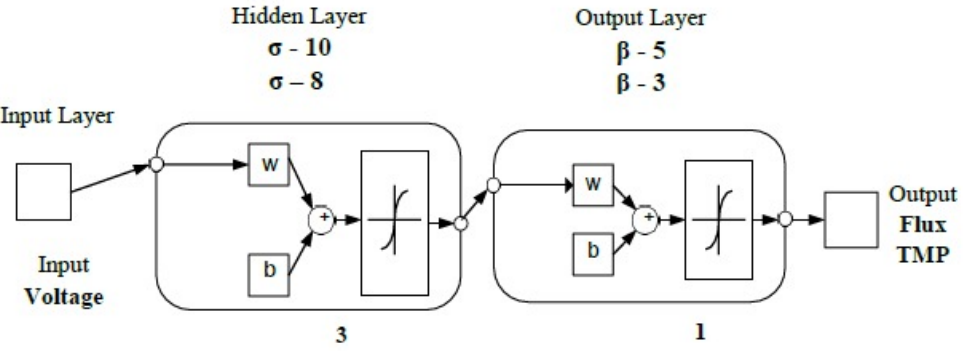
Figure 6. Radial Basis Function Neural Network (RBFNN) structure.